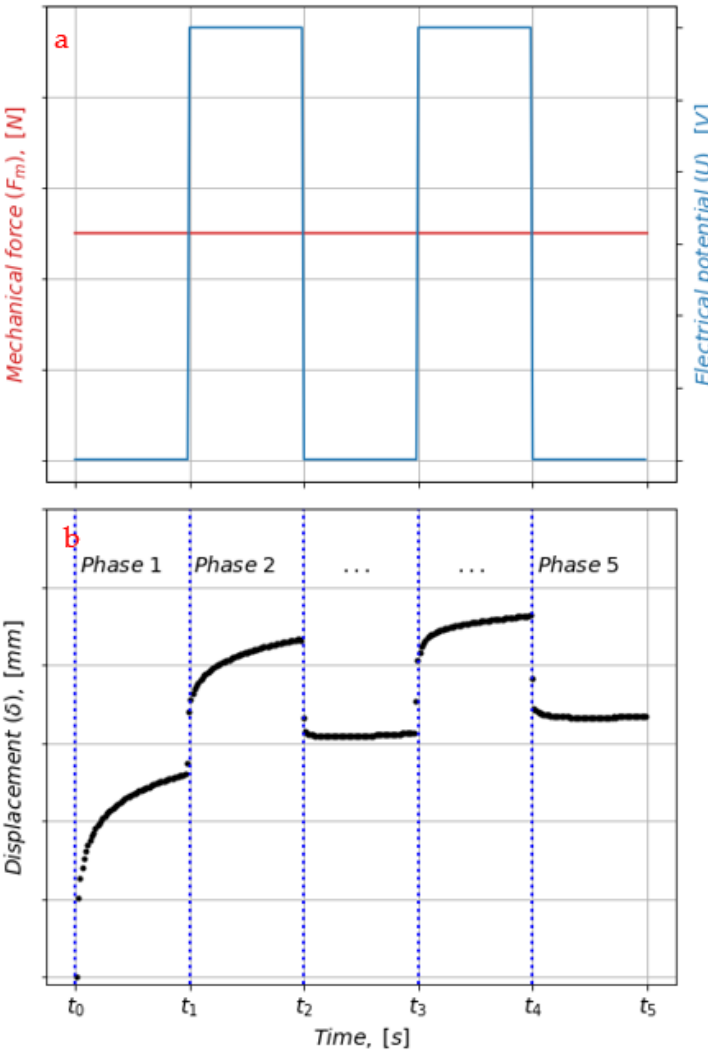
Figure 3. Test conditions illustrating that the gel actuator was subjected to a variety of combinations of constant mechanical force (F m ) and steps of electrical potentials (U). ( a ) Mechanical force (F m ) and steps of electrical potentials (U). ( b ) Displacement ( δ ) of PVC-gel actuator loaded with both mechanical force and electrostatic force. The test setup with the five loading phases was designed so that different viscoelastic responses were expected in the various loading